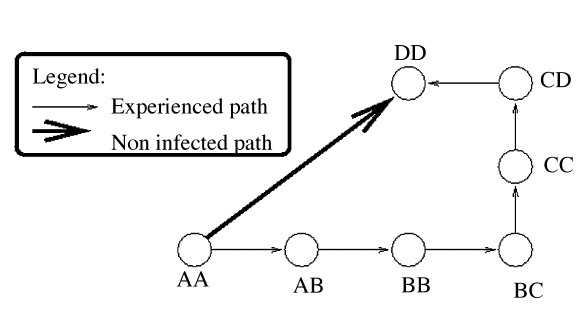
Figure 10. Exploration has led to the creation of the sequence AA, AB, BB, BC, CC, CD, DD. Path between AA and DD cannot be taken because it has never been experienced before.